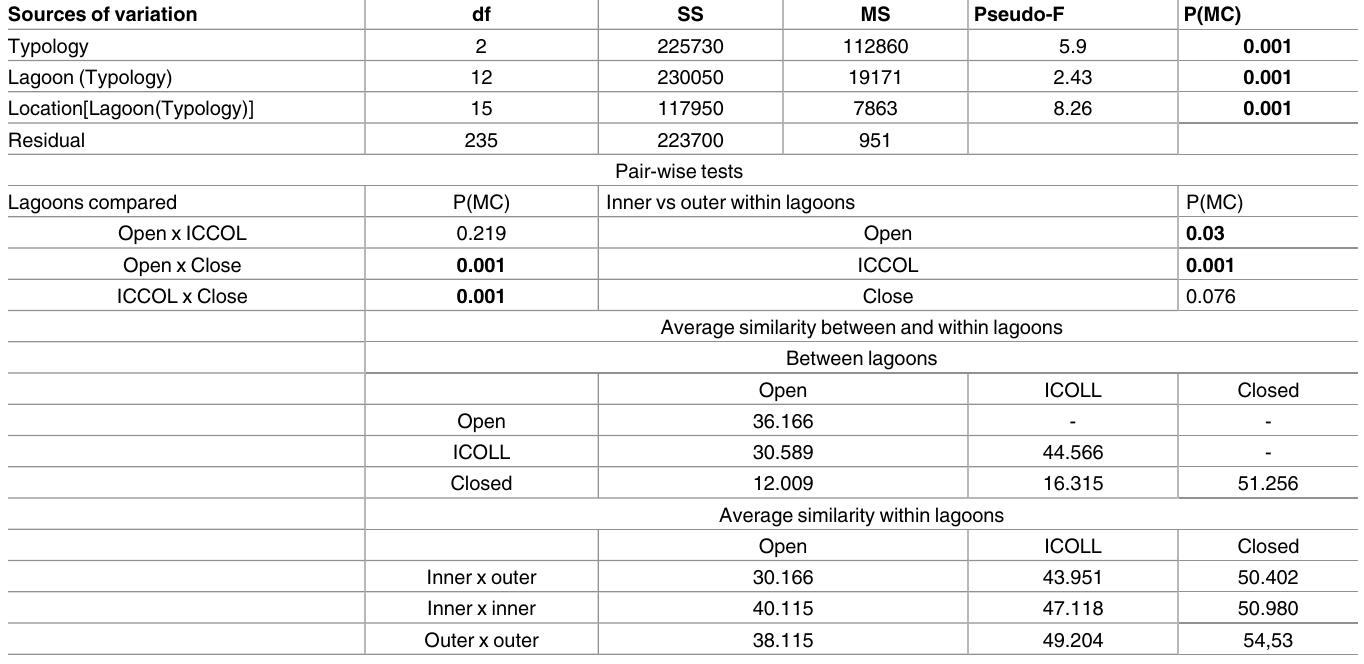
Analyses performed on Bray–Curtis dissimilarities of fourth root transformed nematode abundances. P(MC): p-value obtained with Monte Carlo permutation test. Bold values indicate significant differences at p < 0.05.